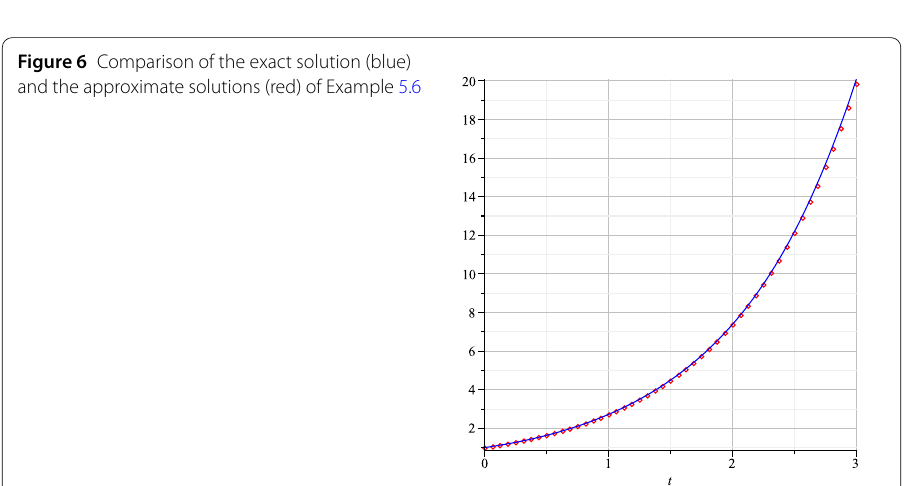
Figure 6 Comparison of the exact solution (blue) and the approximate solutions (red) of Example 5.6